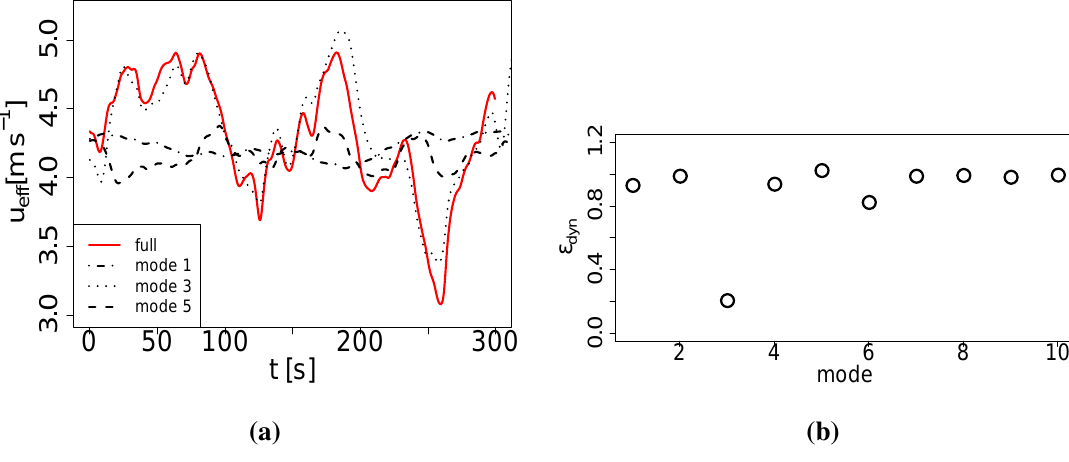
u ( y, z, t ) using only Figure 10. ( a ) Effective velocity u eff for different reconstructions of one single mode (plus mean field); ( b ) dynamical error for reconstructions using a single mode only. The x -axis denotes the number of the mode used for the reconstruction.